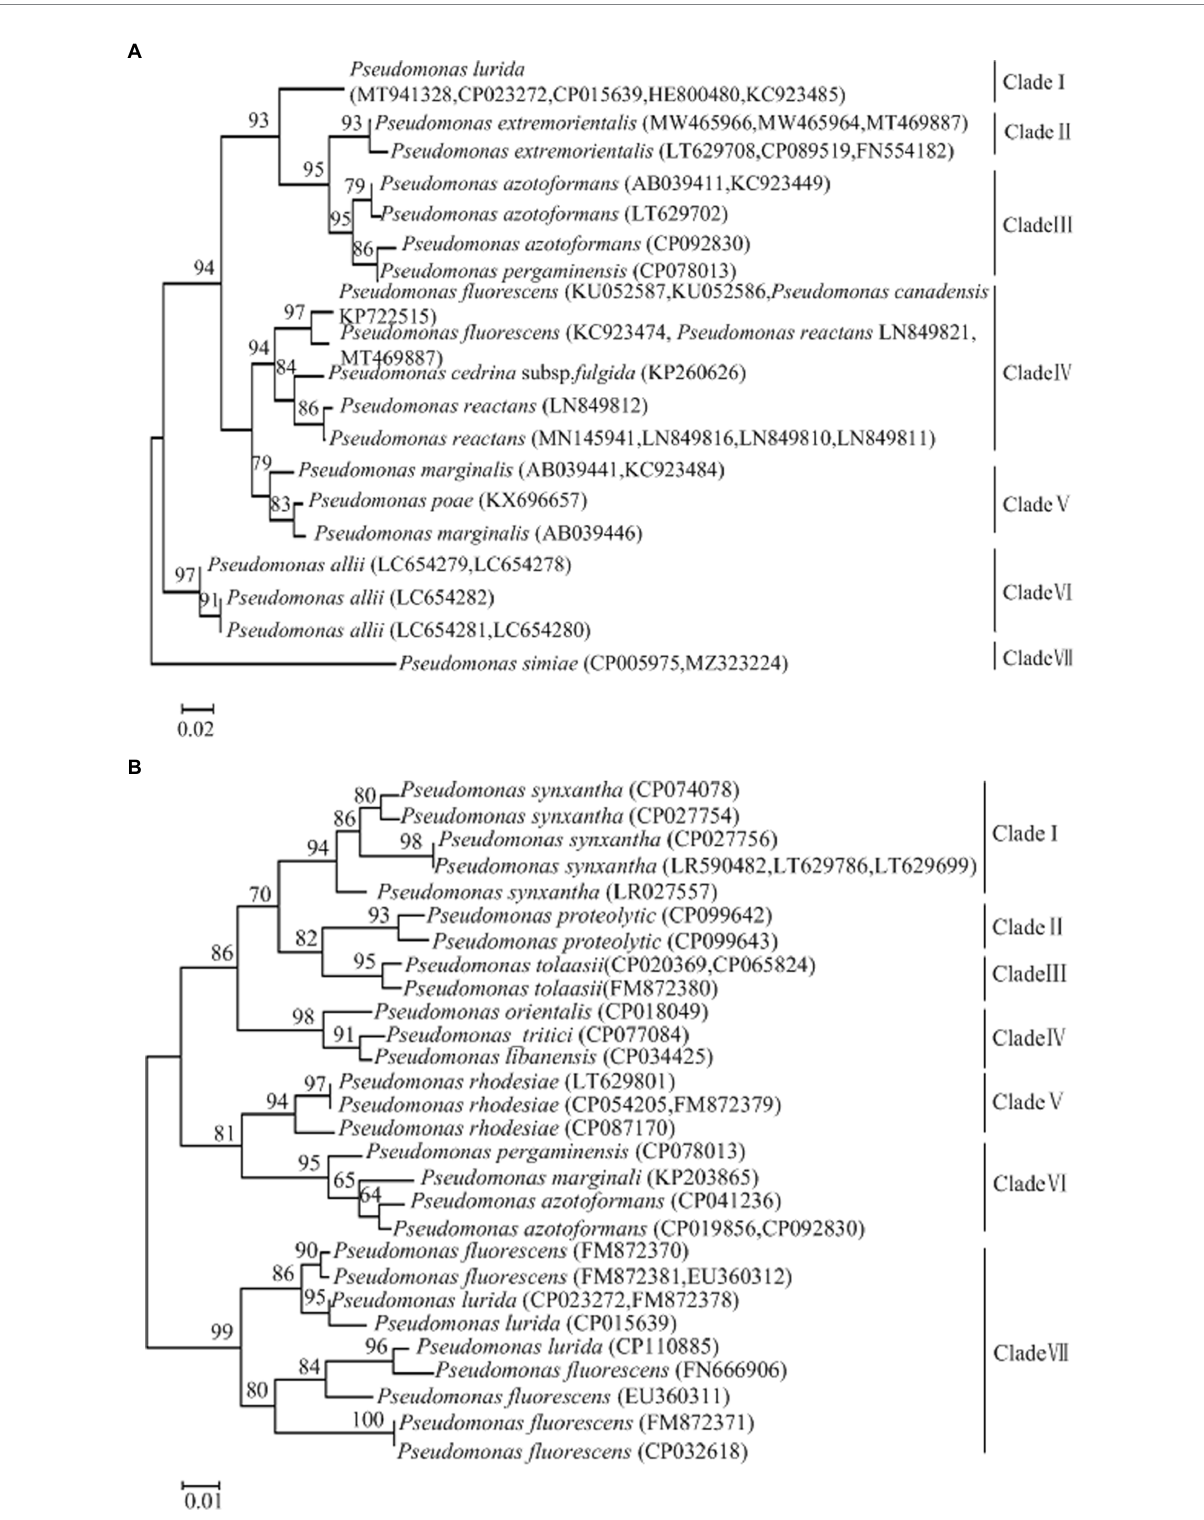
FIGURE 1 (A) Phylogenetic trees of Pseudomonas lurida and related species targeting the gyrB genes. (B) Phylogenetic trees of Pseudomonas lurida and related species targeting the aprX